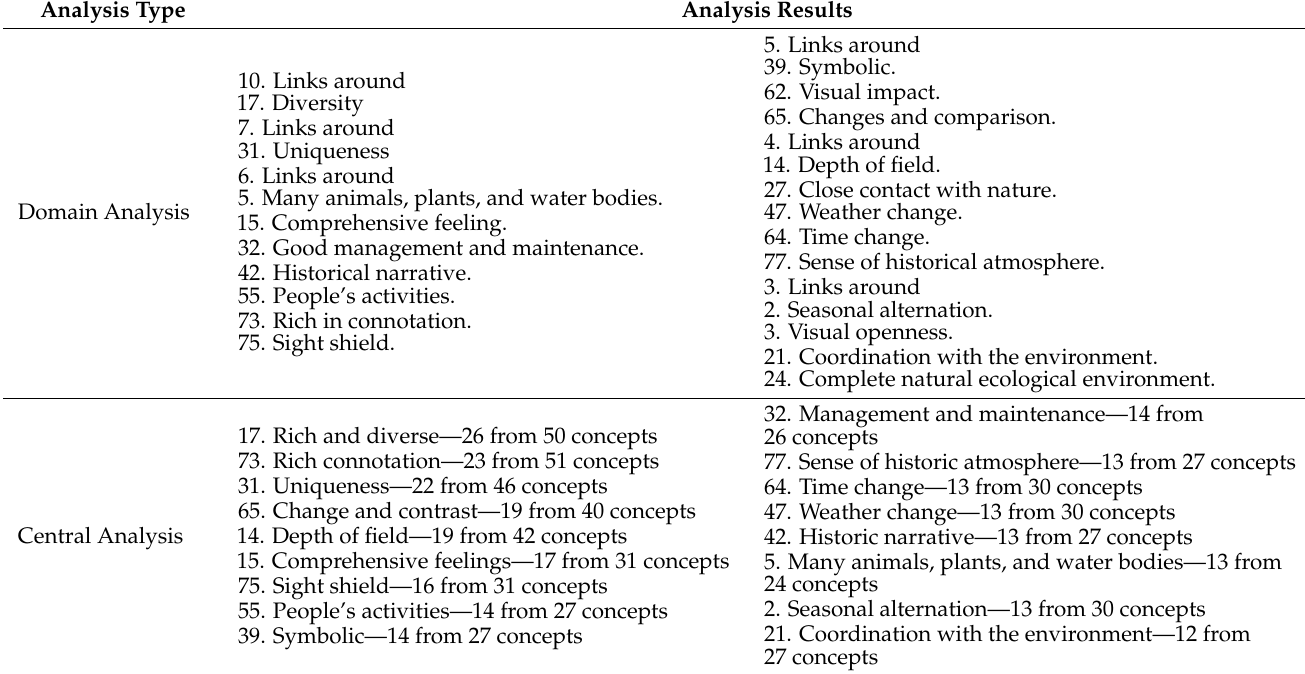
Table 2. Analysis Results of Structural Relationship among Aesthetic Perception